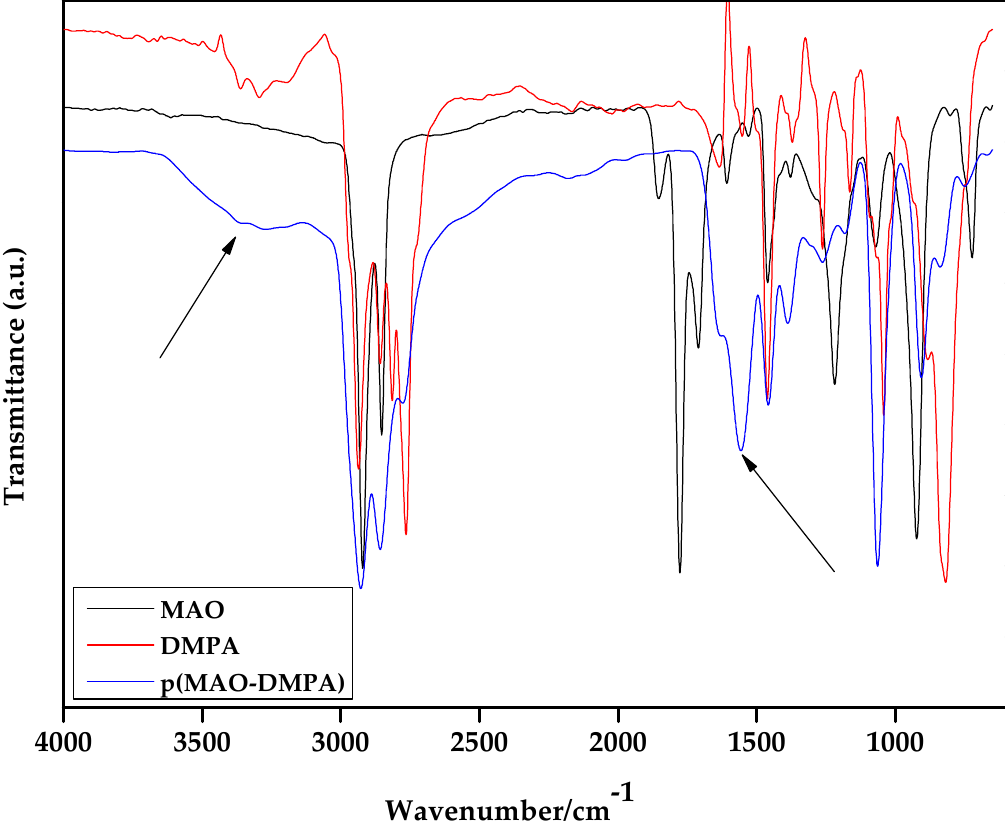
Figure 3. Attenuated total reflectance Fourier transform infrared spectroscopy (ATR-FTIR) spectra of the monomers MAO and DMPA together with that of the synthesized zwitterion, p(MAO-DMPA).